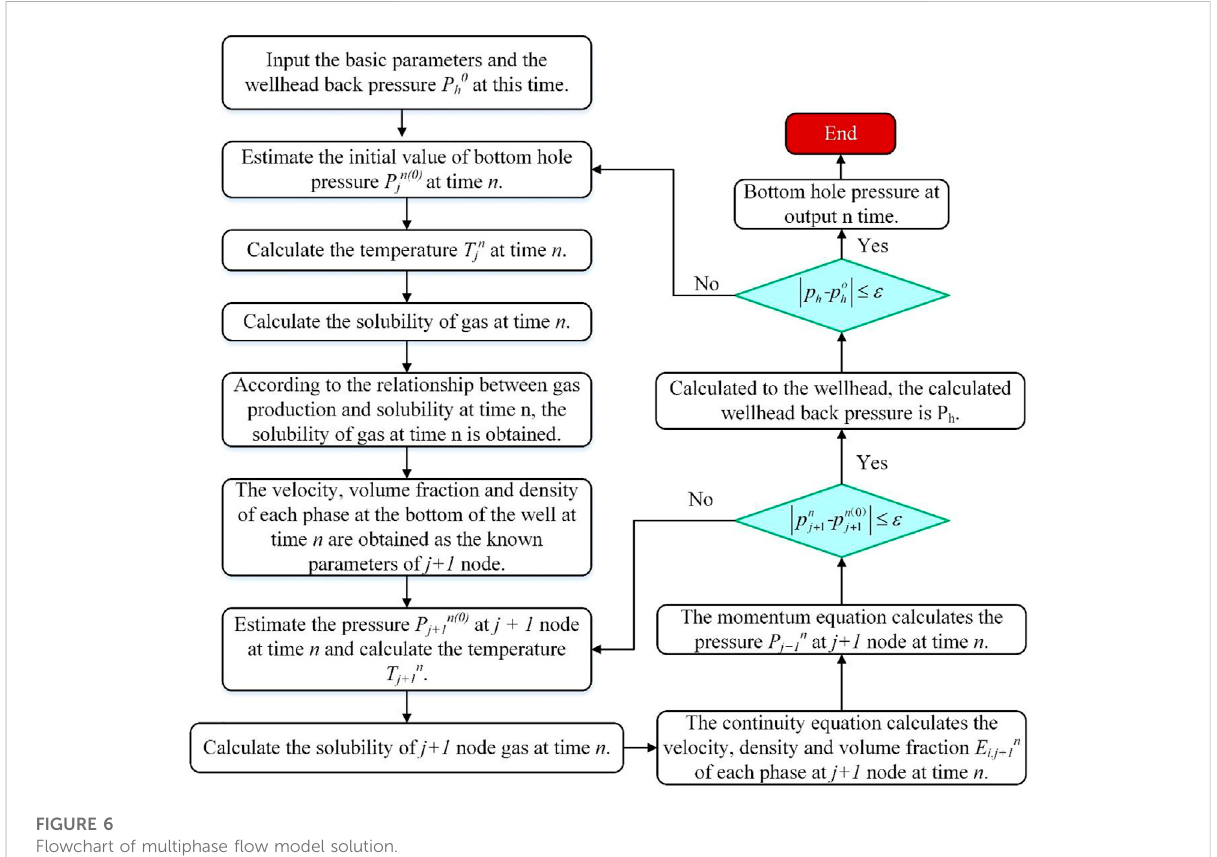
FIGURE 6 Flowchart of multiphase fl ow model solution.